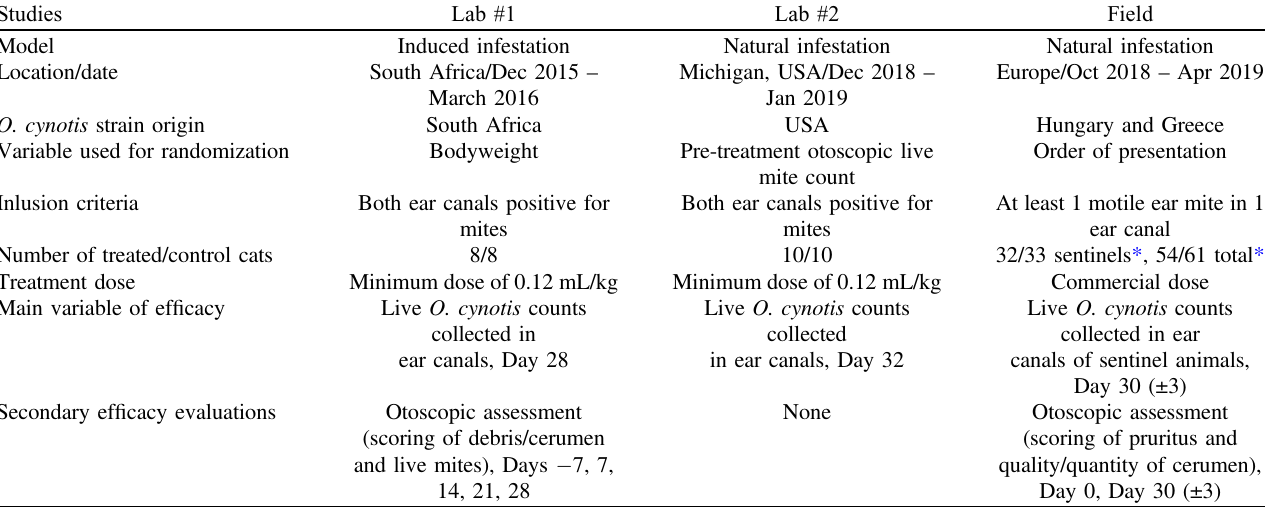
Table 1. Study contexts and